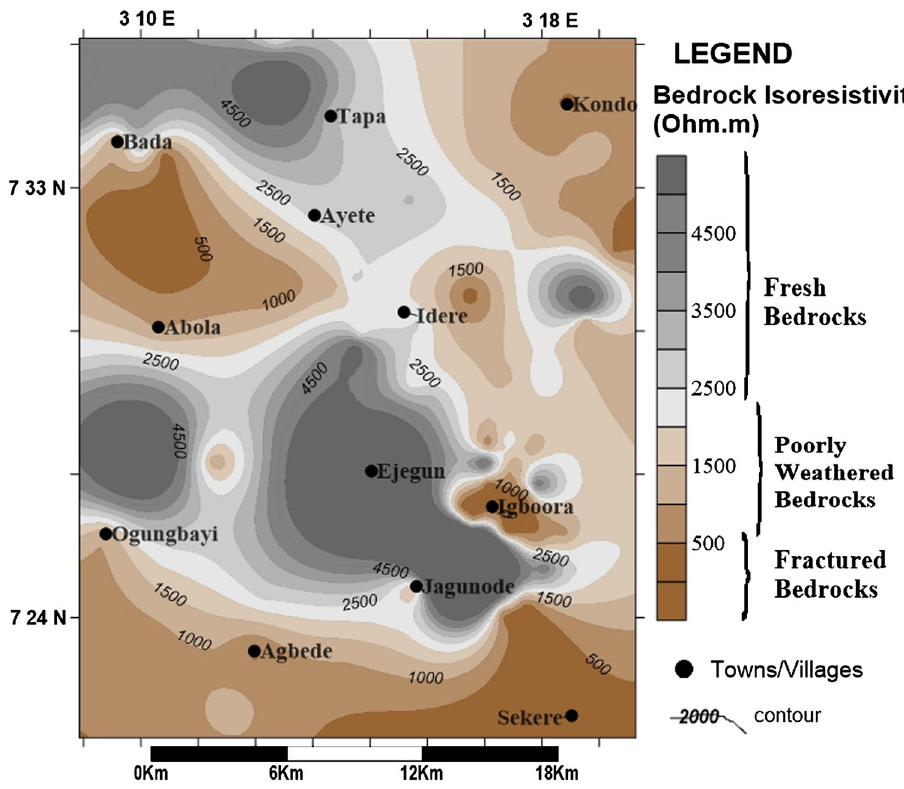
Fig. 8 Bedrock iso-resistivity map of the study